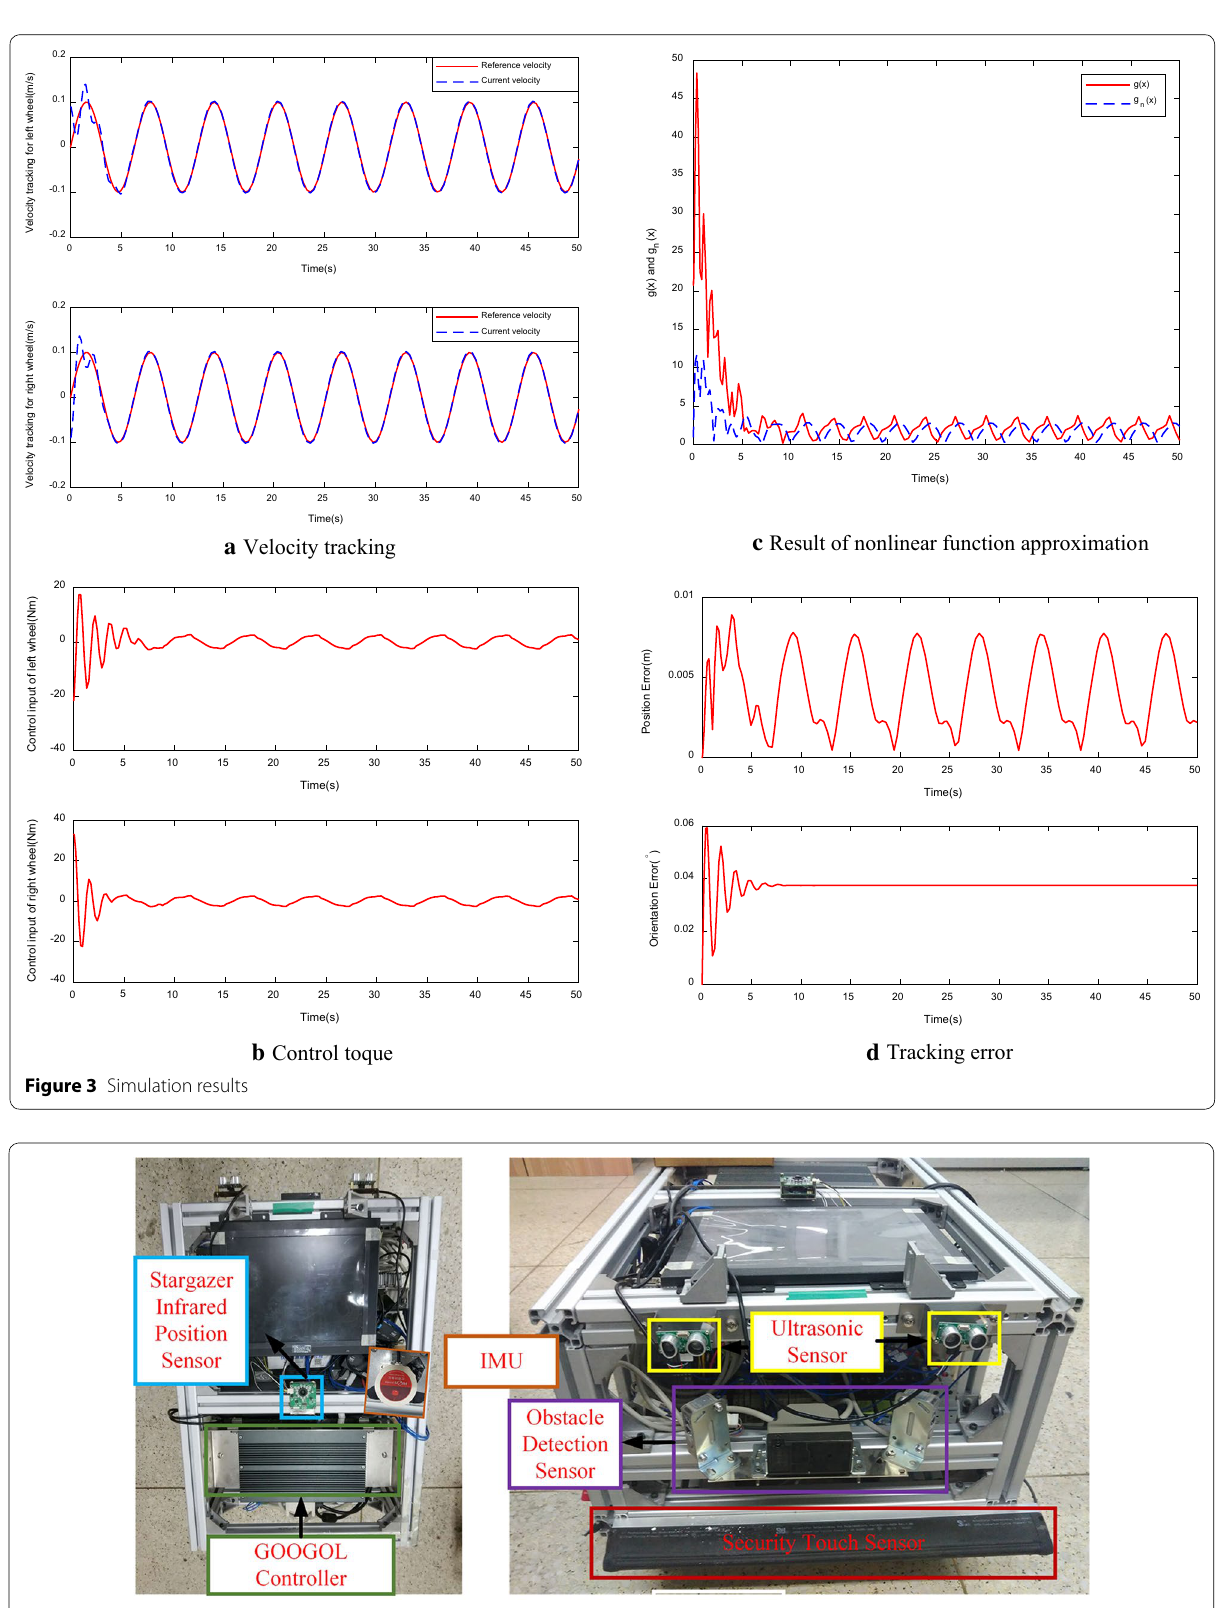
Figure 4 Experiment